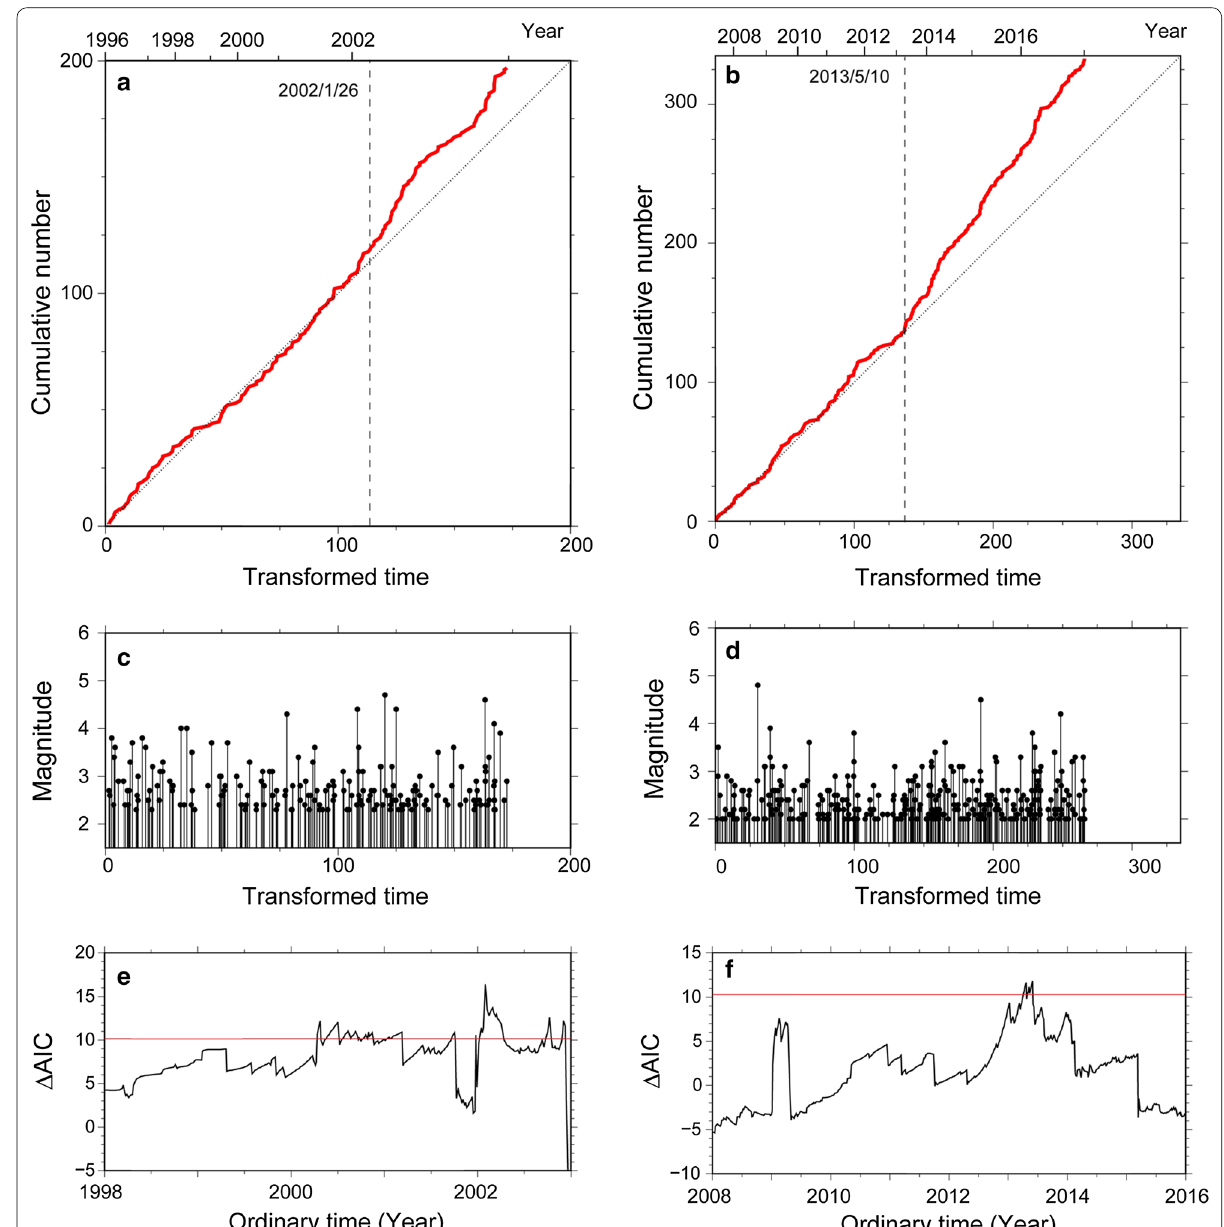
Fig. 8 Cumulative number of events with change point analysis results and the time–magnitude diagram. a Cumulative number of events as a function of the transformed time for Period I. The vertical broken line shows the change point in the ETAS analysis. b The same as a but for Period II. c Magnitude and transformed time diagrams at Period I. d The same as c but for Period II. e ∆AIC for the change point analysis. The horizontal red line shows threshold of the penalty value. f The same as e but for Period